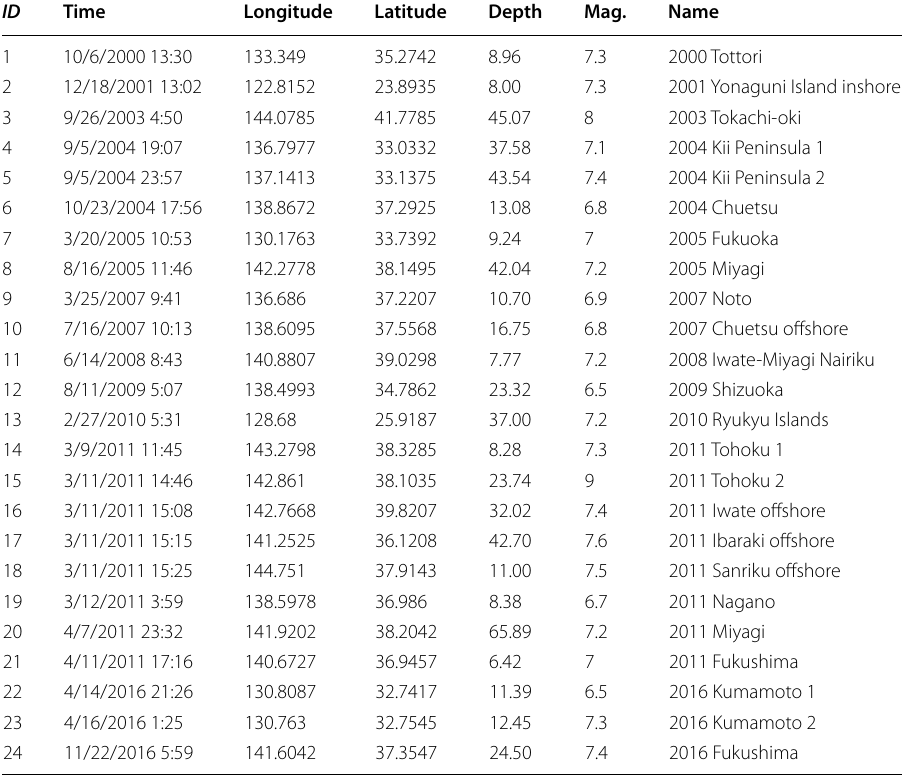
Table 1 Information of 24 major earthquakes selected for